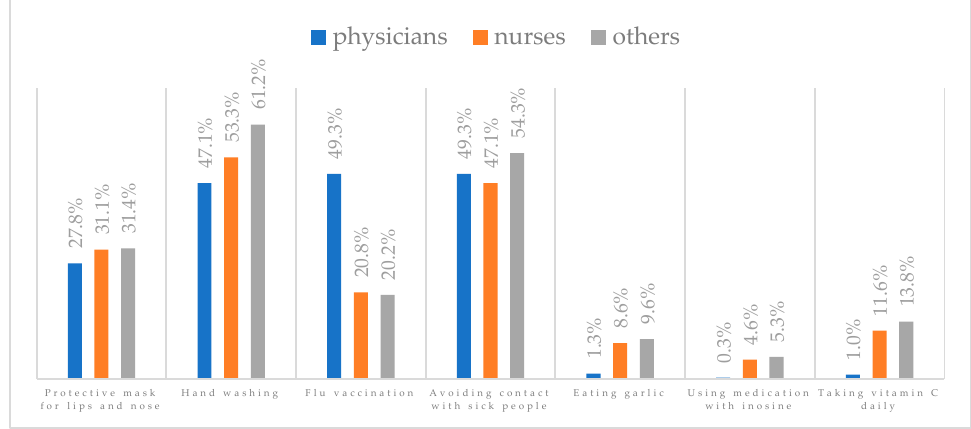
Figure 36. Summary of the indications of each method to prevent influenza virus infection completely effective for each professional group.